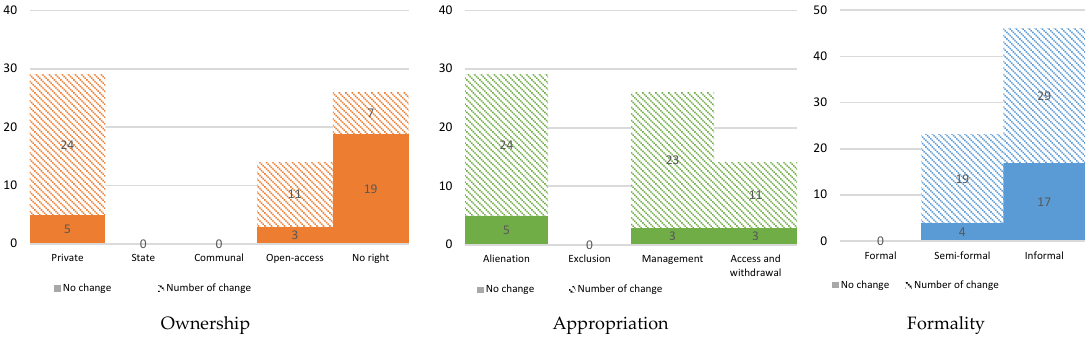
Figure 11. The number of property rights transformation on cultivated lands in MTB.